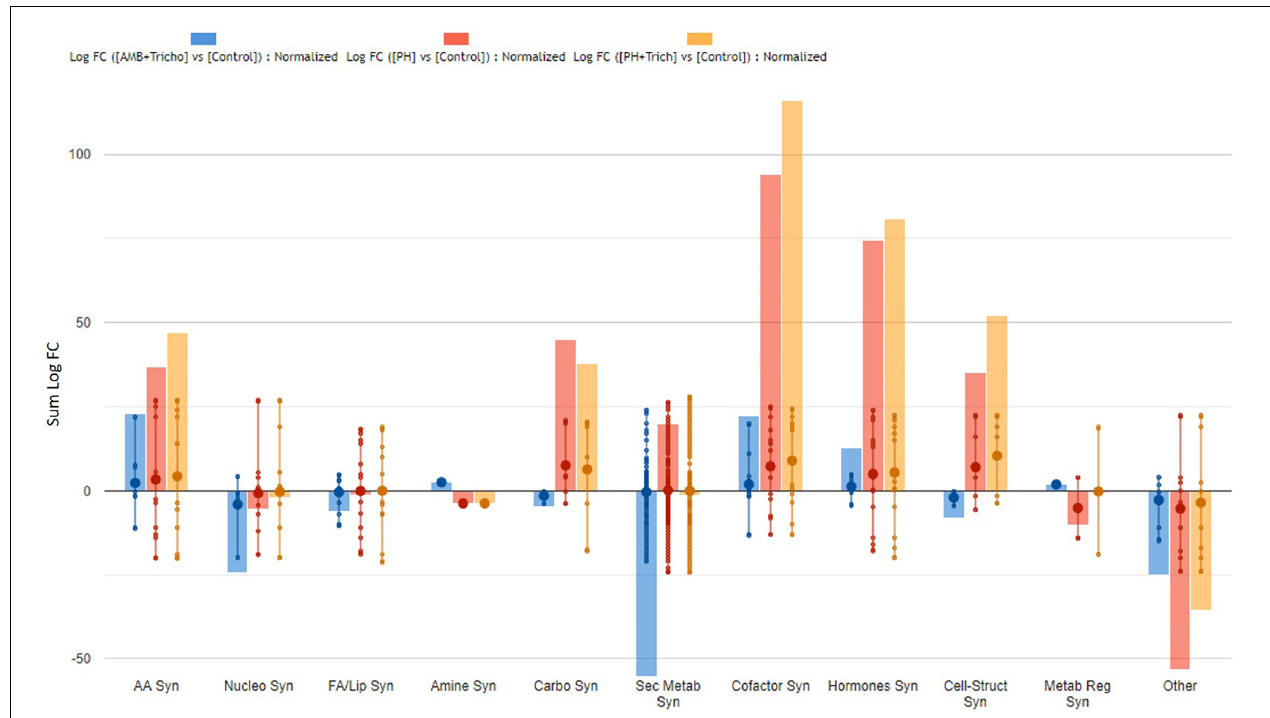
FIGURE 3 | Biosynthesis processes which take place in leaves of maize plants treated with a consortium of arbuscular mycorrhizal fungi (AMF), Trichoderma koningii TK7, and rhizosphere bacteria or with a consortium of Trichoderma koningii TK7 and rhizosphere bacteria (Tricho) plus a protein hydrolyzate-based biostimulant (PH), or with a protein hydrolyzate-based biostimulant (PH). The metabolomic dataset produced through UHPLC-ESI/QTOF-MS was subjected to a Volcano Plot analysis ( P < 0.01, fold-change > 1.2) and differential metabolites were loaded into PlantCyc Pathway Tool (https://www.plantcyc.org/). The x-axis represents each set of subcategories while the y-axis corresponds to the cumulative